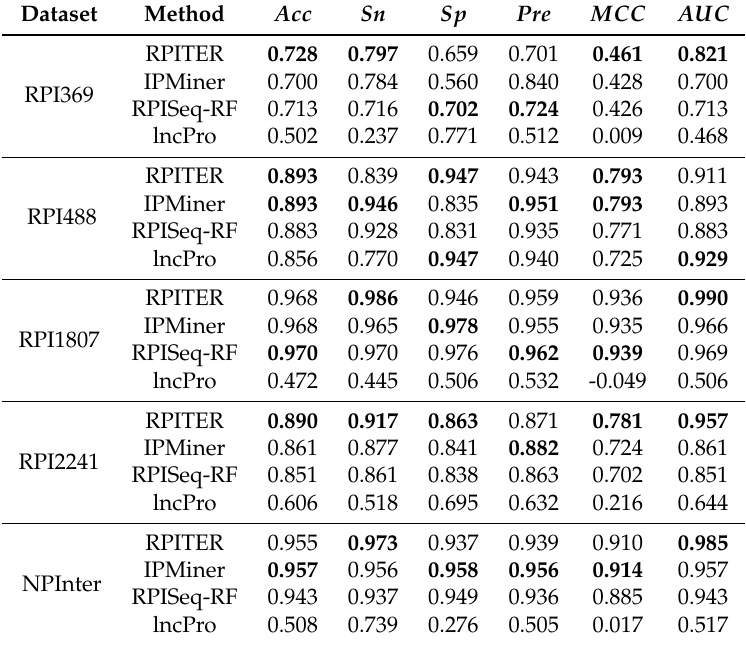
Table 3. Performance comparison of different RNA–protein interaction (RPI) prediction methods on five benchmark datasets by five-fold cross